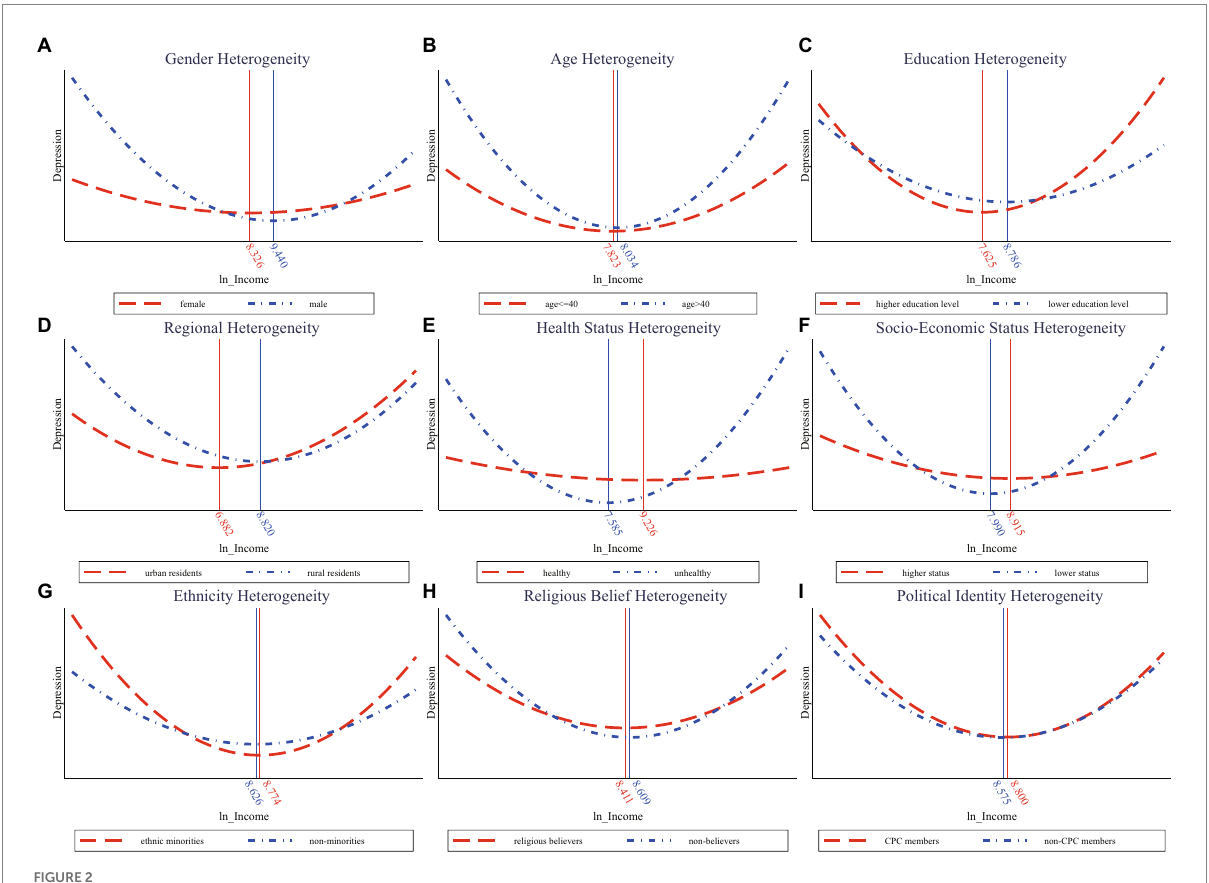
FIGURE 2 (A-I) Heterogeneities in the effects of income on